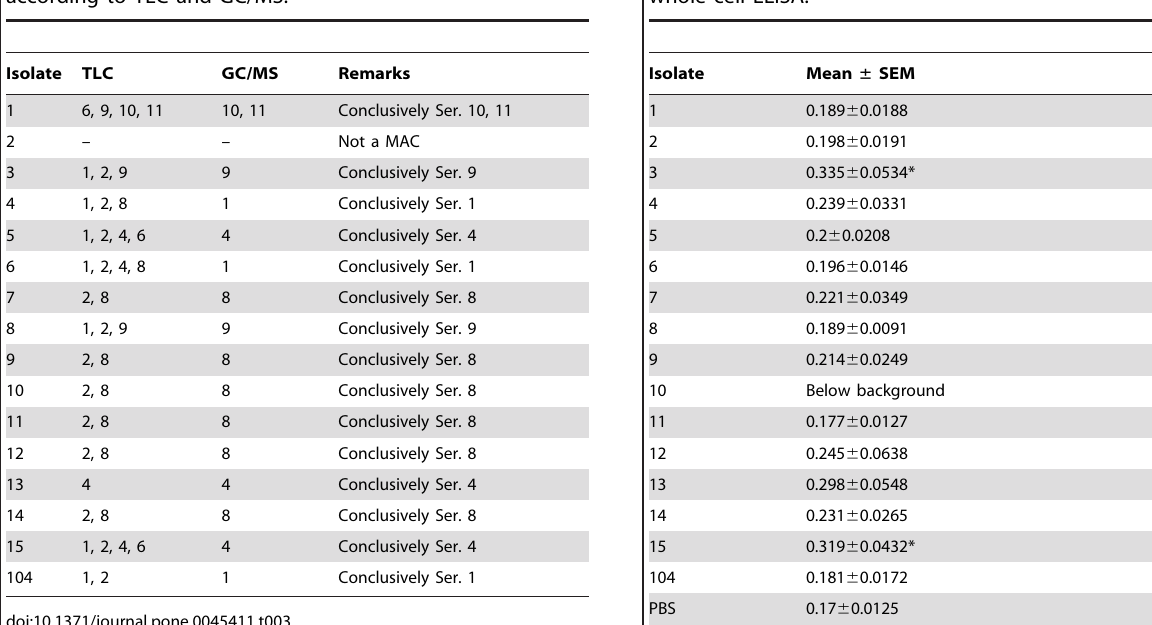
Table 4. Detection of ManLAM on the bacterial surface by whole cell